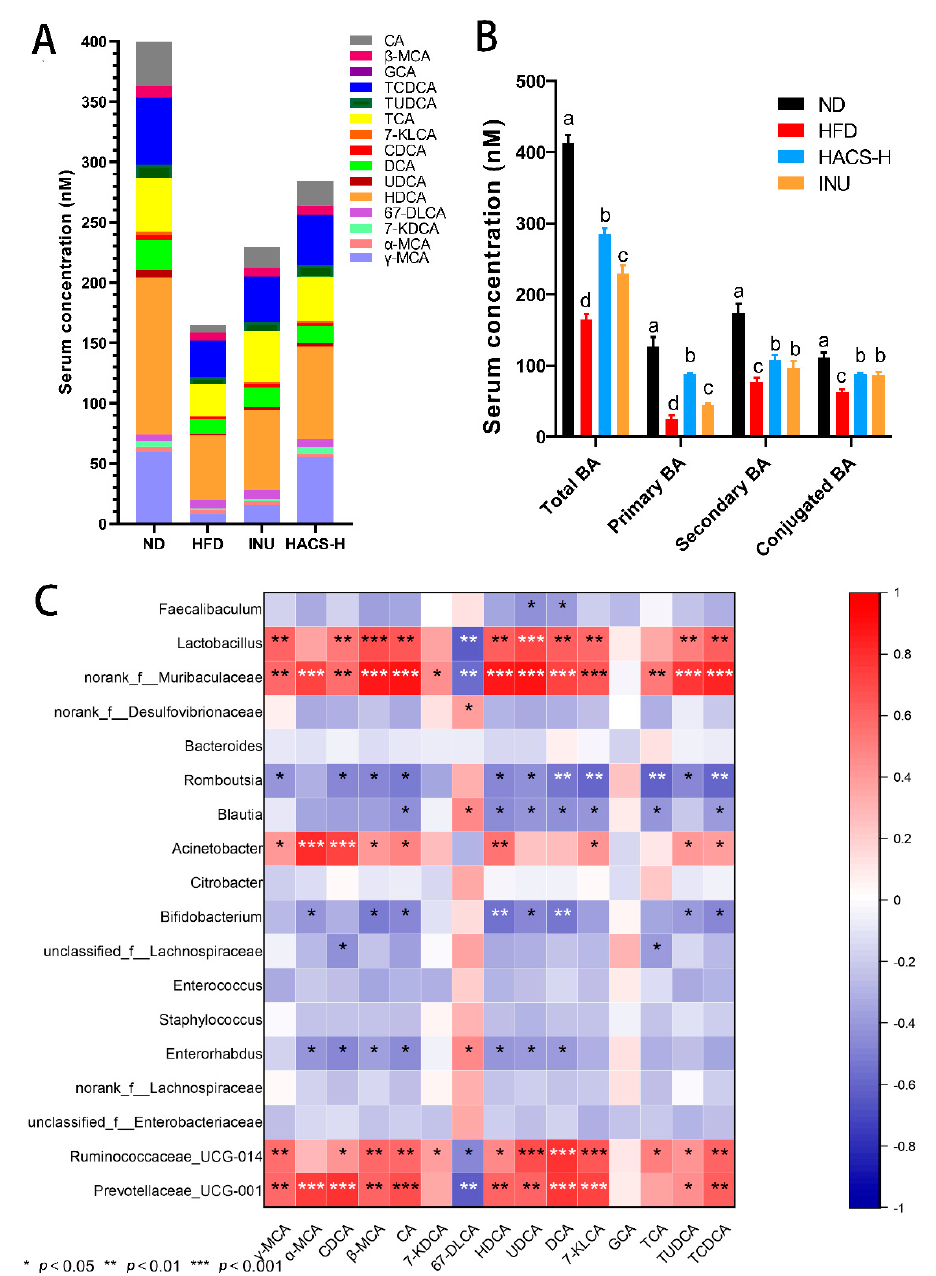
Figure 5. Effects of HACS treatment on serum bile acids. ( A ) Concentration of 15 individual bile acids in serum; ( B ) concentration of primary, secondary, and conjugated bile acids in serum, and ( C ) Spearman correlation between bacterial composition and bile acids. ND, normal diet; HFD, high fat diet; HACS-L, high fat diet + 0.25 g/kg HACS; HACS-H, high fat diet + 0.5 g/kg HACS; and INU, high fat diet + 0.5 g/kg inulin. CA: cholic acid; β -MCA: β -mouse cholic acid; GCA: glycocholic acid; TCDCA: sodium taurochenodeoxycholic acid; TUDCA: tauroursodeoxycholic acid; TCA: taurocholic acid; 7-KLCA: 7-ketocornerstone cholic acid; CDCA: chenodeoxycholic acid; DCA: deoxycholic acid; UDCA: ursodeoxycholic acid; HDCA: hyodeoxycholic acid; 67-DLCA: 6, 7-diketolithocholic acid; 7-KDCA: 7-ketodeoxycholic acid; α -MCA: α -mouse cholic acid; and γ -MCA: gamma-mouse cholic acid. Data were expressed as the mean ± SD ( n = 5 per group). Different lowercase letters represent significant differences (* p < 0.05), and the same lowercase letters represent no significant differences (* p ≥ 0.05) ( B ); red represents a positive correlation, and blue represents a negative correlation. * p < 0.05, ** p < 0.01, *** p < 0.001 ( C ).